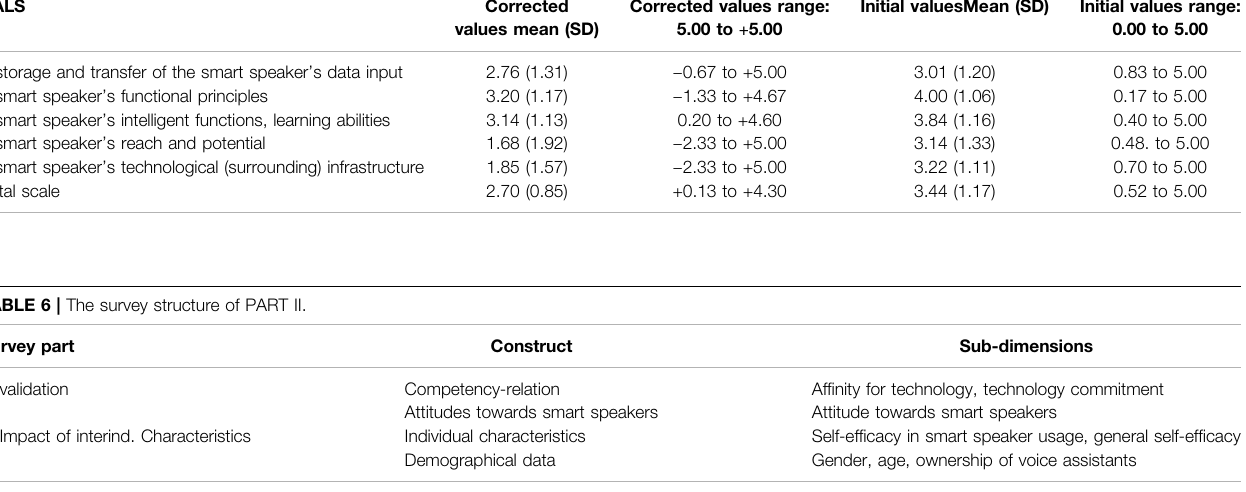
Corrected values range: Initial valuesMean (SD) Initial values range: values mean (SD) 5.00 to + 5.00 0.00 to 5.00